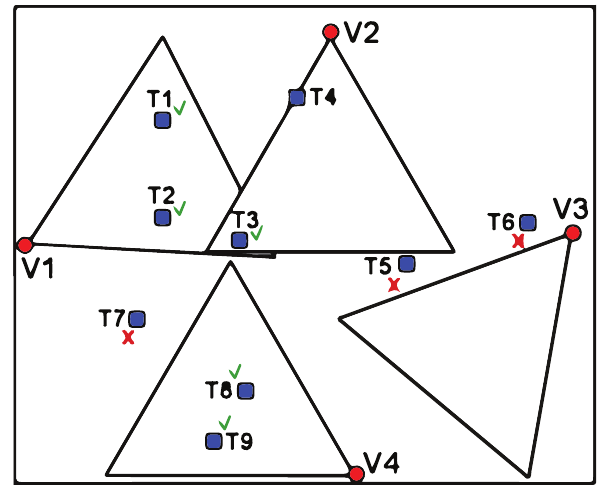
Figure 2. WVSN for target